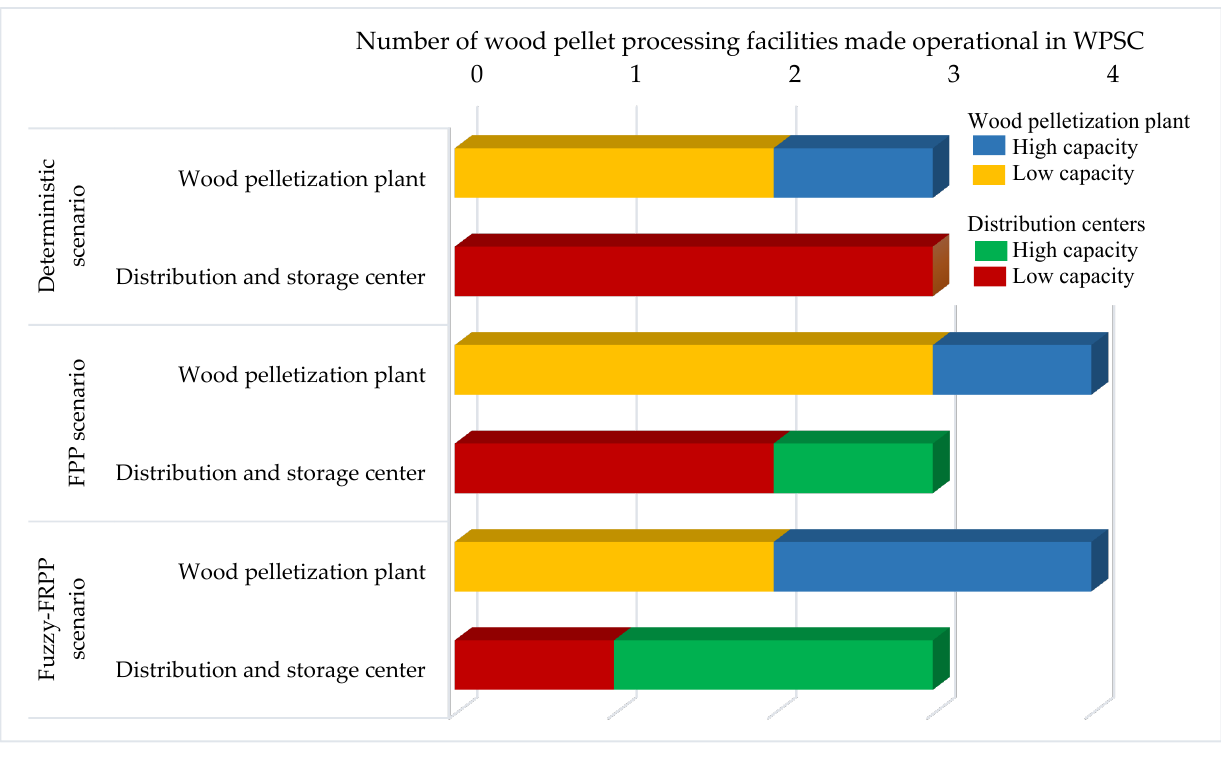
Figure 5. Impact of specific uncertainty handling technique on the WPP-SCND model’s facility capacity level decision.